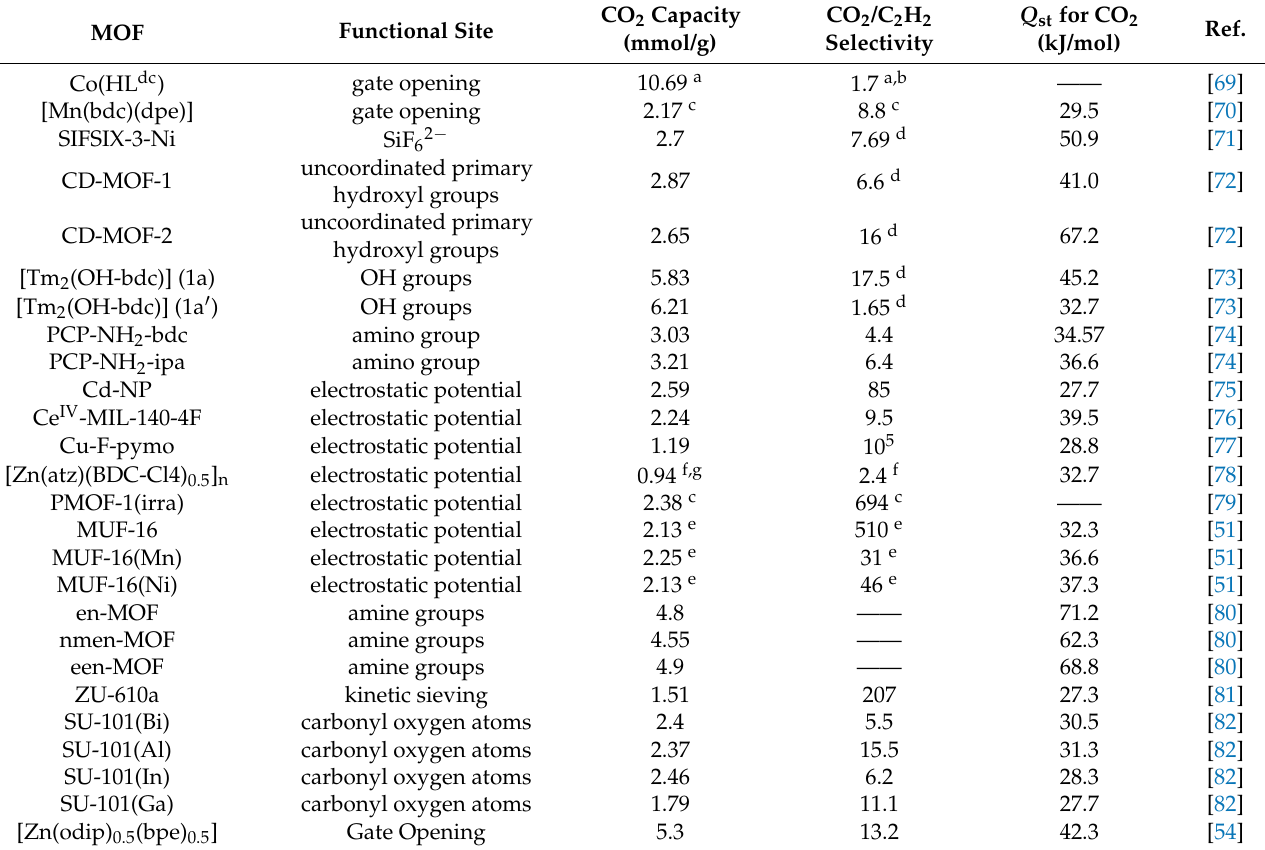
Table 3. Representative MOFs for CO 2 -selective capture from CO 2 /C 2 H 2 mixture